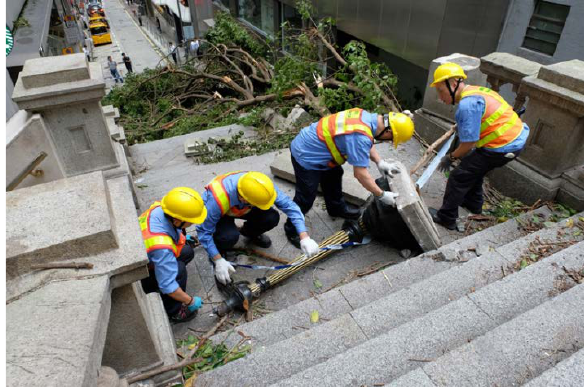
Figure 6: 3DSU conducting 3D laser scanning by terrestrial laser scanner on site after the damage.